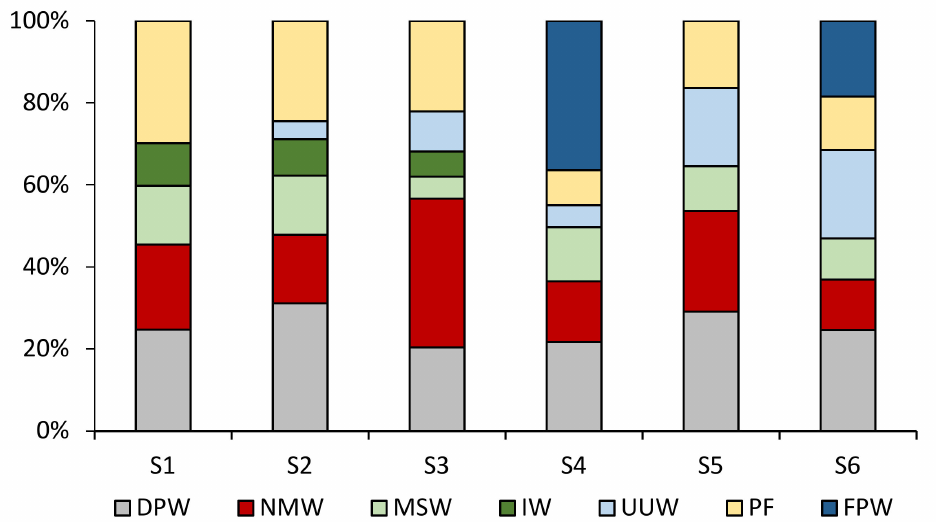
Figure 11. Source of plastic pollution in different study areas. (DPW—domestic plastic waste, NMW— nearby market waste, MSW—municipal solid waste, IW—industrial waste, UUW—upstream urban waste, PF—pluvial flow, FPW—fish-market plastic